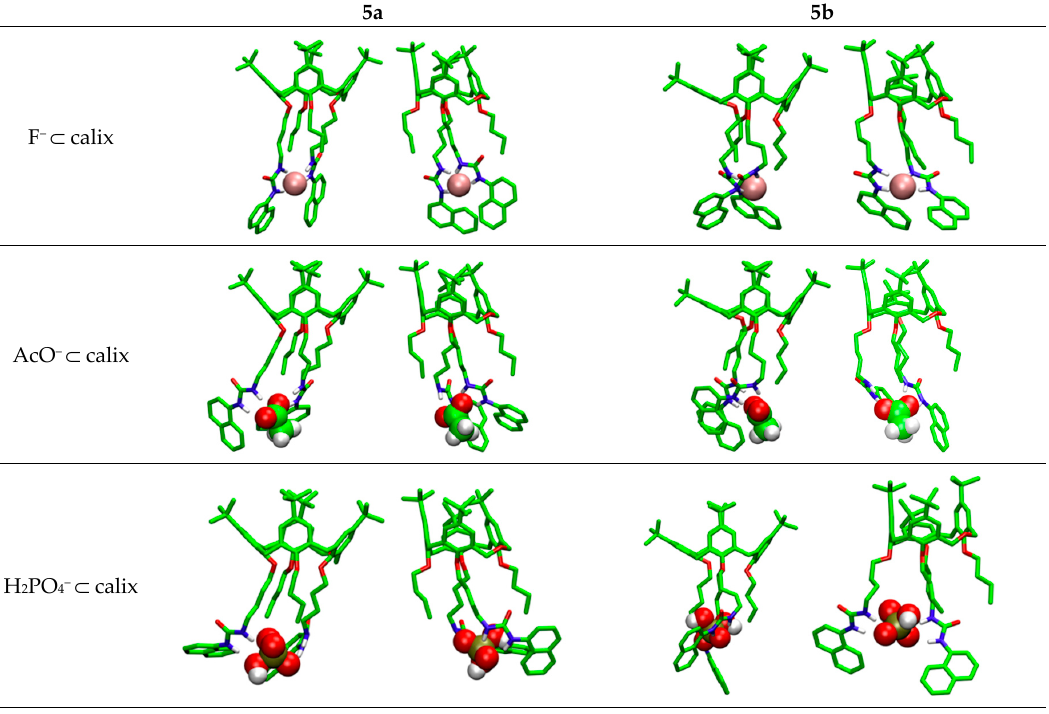
Figure 9. Structures of the X − ⊂ Naph-urea complexes after QM optimization (orthogonal views). The atomic species are represented in CPK colours, except carbons that are in green.